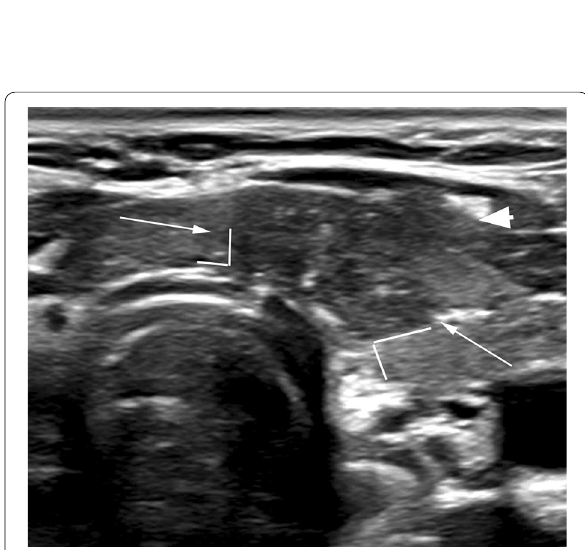
Fig. 11 27-Year-old female with 14 mm PTC in left isthmus of thyroid gland. The nodule has a right angle/obtuse angle contact with the trachea which suggests a high risk of invasion into trachea. In addition, there is gross ETE noted anteriorly with disruption of the echogenic line and tumor extension to the strap muscles (arrowhead). The patient was not offered AS in our study